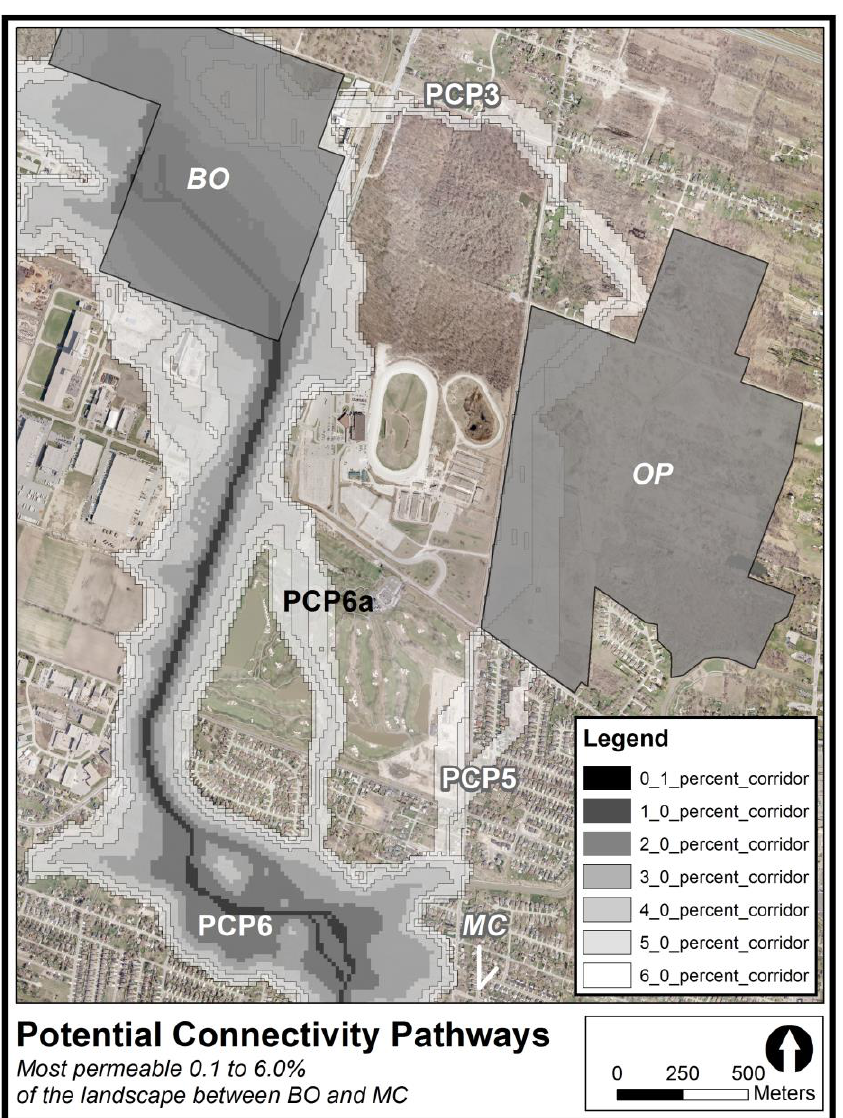
Figure 9. The most permeable 0.1% to 6.0% of the landscape between Black Oak Heritage Park (BO) and Marentette Drain Woodlots (MC) for the Massasauga rattlesnake in Windsor / LaSalle, Ontario as indicated by a cost-surface GIS analysis.